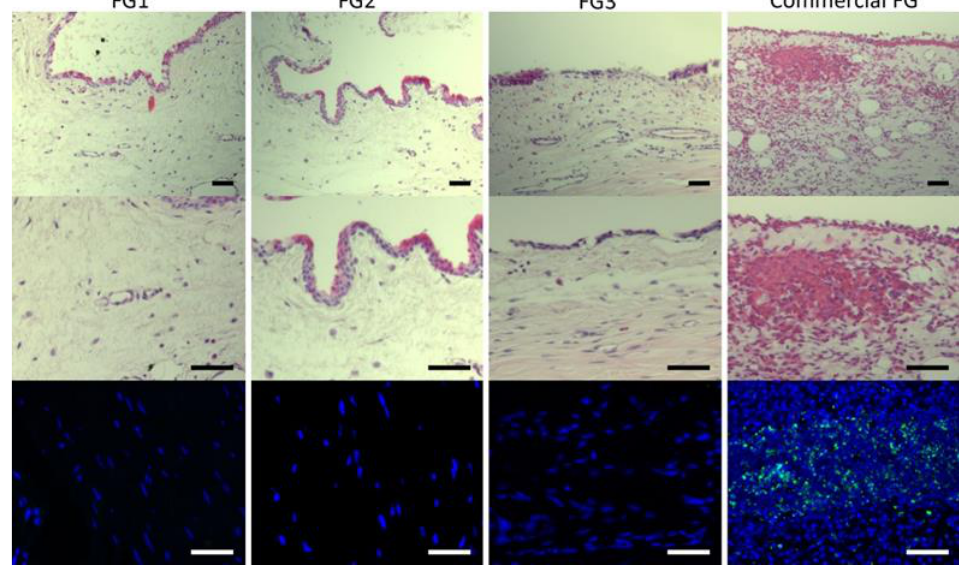
Figure 5. H&E and IL-6 immunofluorescence stains of a representative sample of each FG group. No inflammatory cells and no edema were observed in FG1, FG2, or FG3 samples. Commercial FG showed inflammatory cells and edema. Scale bars: 50 µm. FG: bio-based fibrin glue; IL-6: interleu- kin-6.